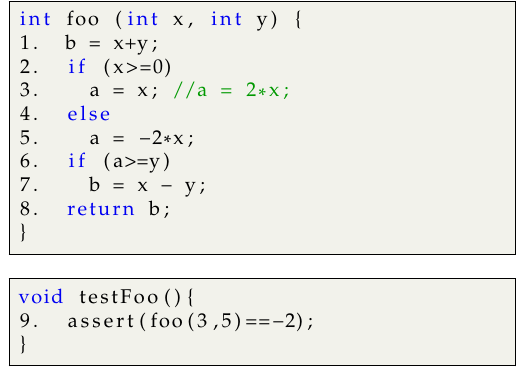
Figure 1. Buggy program and a failing